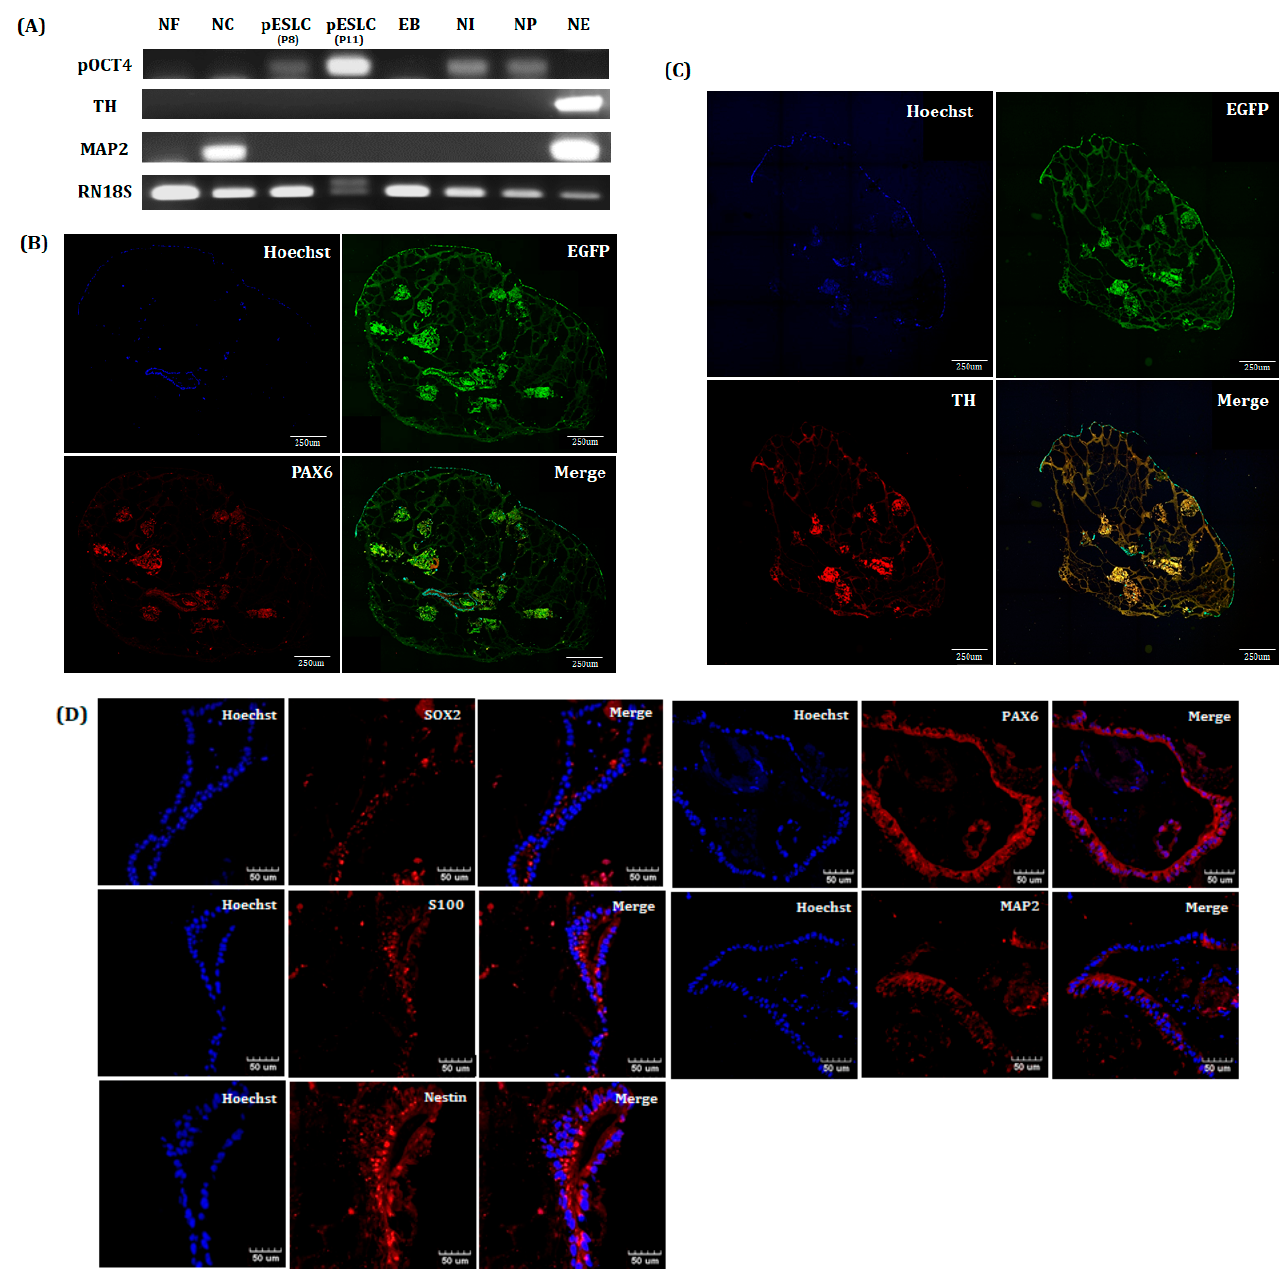
Figure 6. Characterization of D61 neuro-organoid from Yucatan EGFP pESLC lines. ( A ) Analysis of gene expression by differentiation step by PCR. RN18s was used as a control. NF: normal fibroblast, NC: neural cell, EB: embryonic body, NI: neural induction, NP: neural patterning, NE: neural expansion. ( B–D ) Immunofluorescence staining of neuro-organoids. Scale bar = 50 or 250 µm.